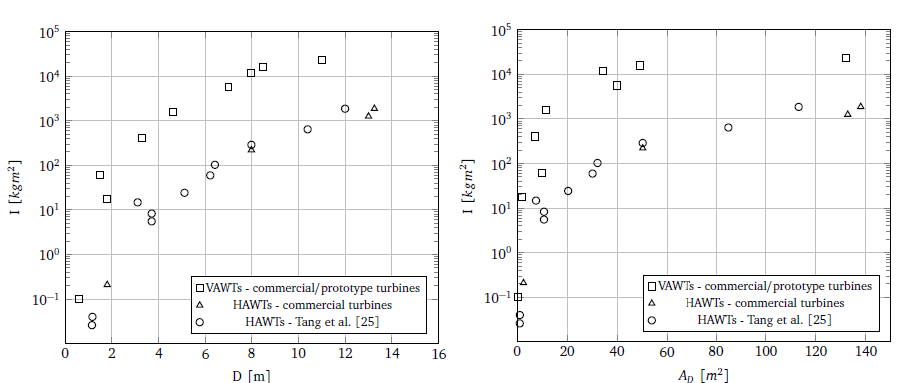
Figure 2. Moments of inertia of (H-type) commercial/prototype VAWTs and HAWT, according to diameter ( left ) and rotor swept area ( right